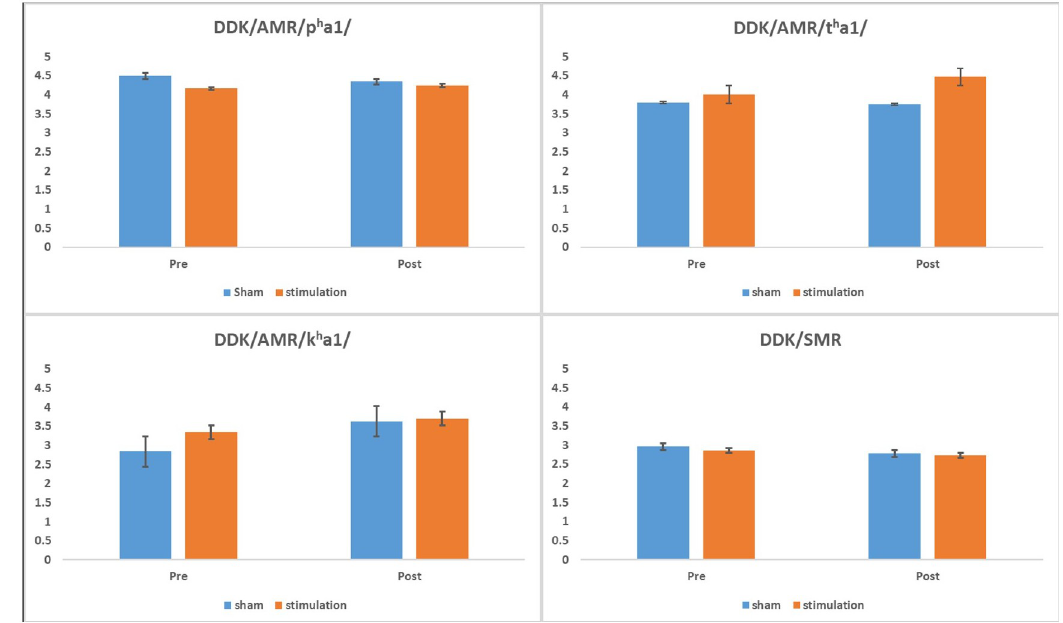
Fig 5. Mean (and standard error) DDK rates for the stimulation and sham groups measured before and after treatment.